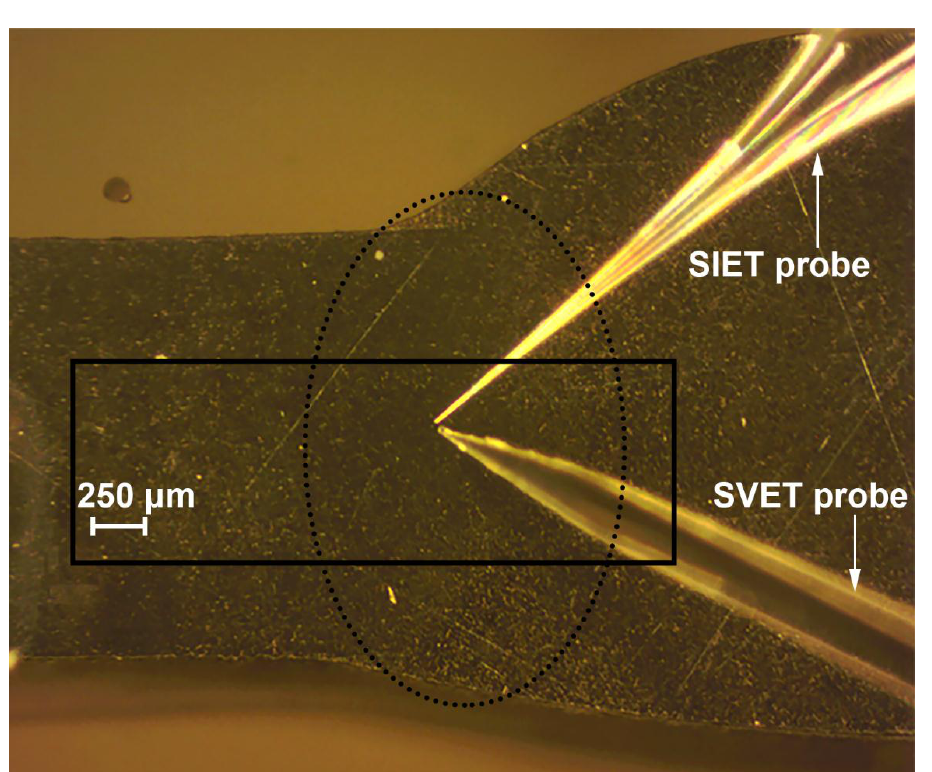
Figure 2. The investigated welded joint area of the 1579 aluminium alloy sample before SVET and SIET experiments. The investigated area is outlined by a frame, and the weld interface is marked by a dotted line.